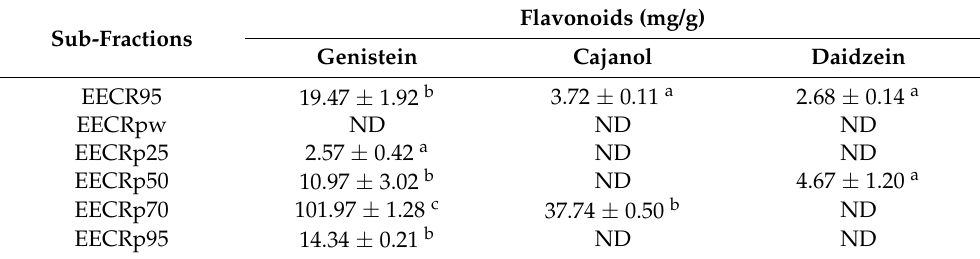
Table 1 indicated that genistein, cajanol and daidzein were the major flavonoids in EECR95, and the contents were 19.47-, 3.72- and 2.68- mg/g, respectively. Genistein content (101.97 mg/g DW) was the highest followed by cajanol (37.74 mg/g DW) in EECRp70, and